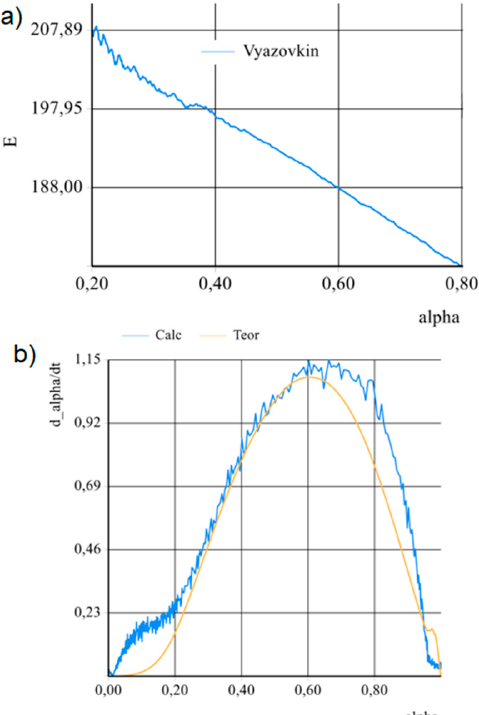
Figure 3. Kinetic calculation of the experimental curves. ( a ) Activation energy in function of conversion degree and ( b ) degradation rate in function of conversion degree.